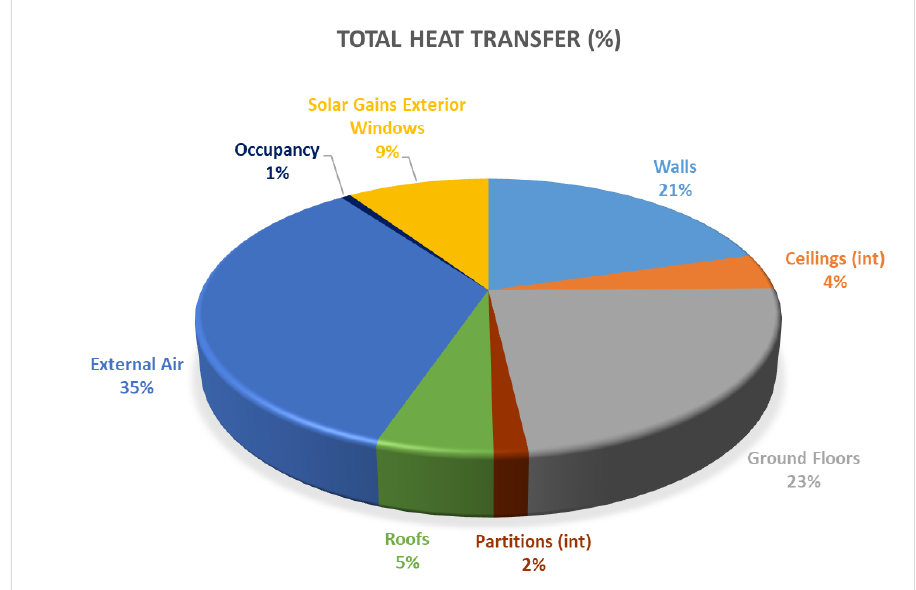
Figure 27. Total heat transfer.